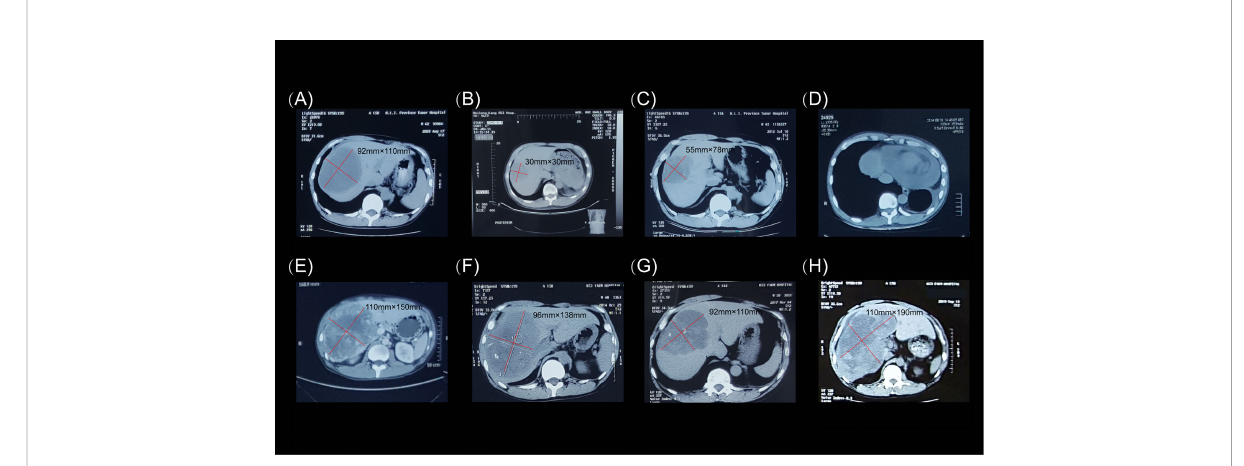
FIGURE 3 Computed tomography images of the hepatic extra-gastrointestinal stromal tumor. (A) In August 2009, prior to imatinib mesylate administration (400 mg once daily), the tumor mass measured 92 × 110 mm. (B) In January 2011, routine computed tomography examination showed that the lesion in the right hepatic lobe had shrunk to 30 × 30 mm. (C) In July 2012, the lesion grew to 55 × 78 mm. (D) Pericardial effusion was observed in August 2014. (E) In September 2014, the lesion measured 110 × 150 mm. (F) Before the patient was switched to sunitinib malate therapy (50 mg once daily on a 4/2 schedule), the tumor mass measured 96 × 138 mm. (G) In March 2017, the tumor was 92 × 110 mm in size. (H) The fi nal computed tomography examination in October 2019 showed that the tumor mass measured 110 × 190